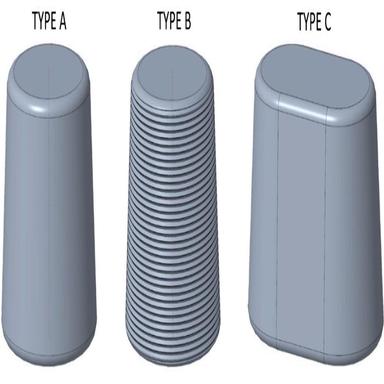
Diagram showing three taper types in relation to Table 1.